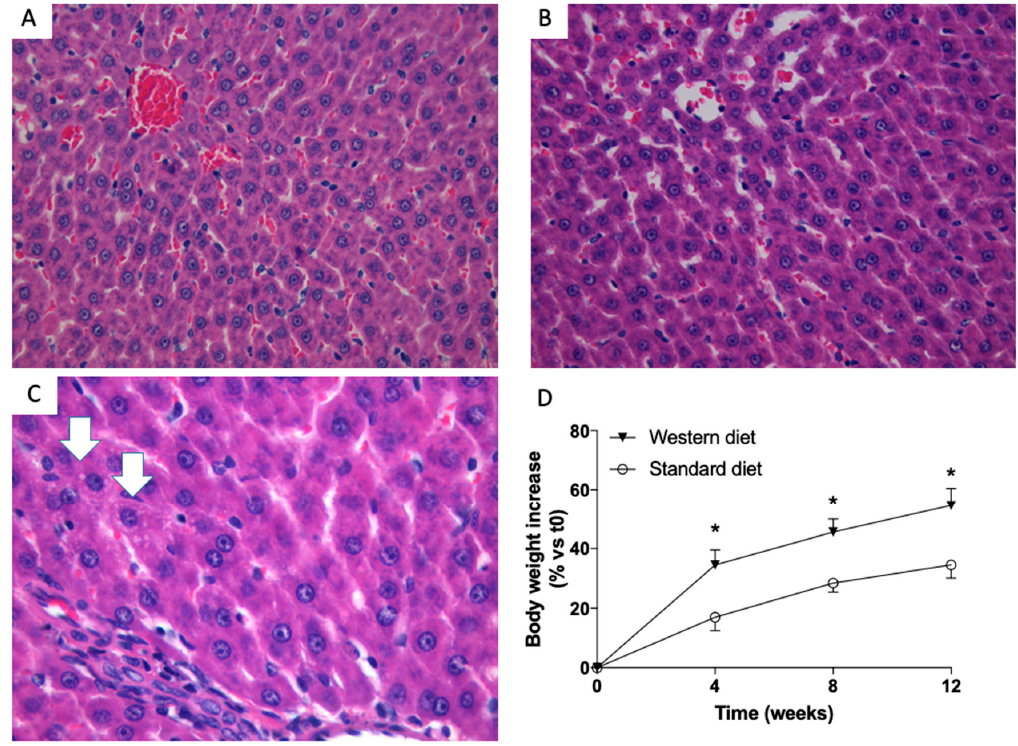
Figure 1. Liver histology of rats. Representative photomicrographs of liver tissue from a rat fed with a standard ( A ) and Western ( B ) diet (hematoxylin and eosin—H&E staining,). At 40 × magnification, the histology of rats fed with a standard and Western diet were indistinguishable. At 63 × magnification, small droplets were present in some hepatocytes of Western diet-fed rats ( C , white arrows). Western-diet induced an increase in rat body weight. ( D ) Significantly higher body weight increases in rats fed with a western diet (triangles) diet vs. rats fed with standard diet (dots). * p < 0.05 vs. rats fed with standard diet. Table 1. Biochemical parameters of liver function in standard and Western diet rats.